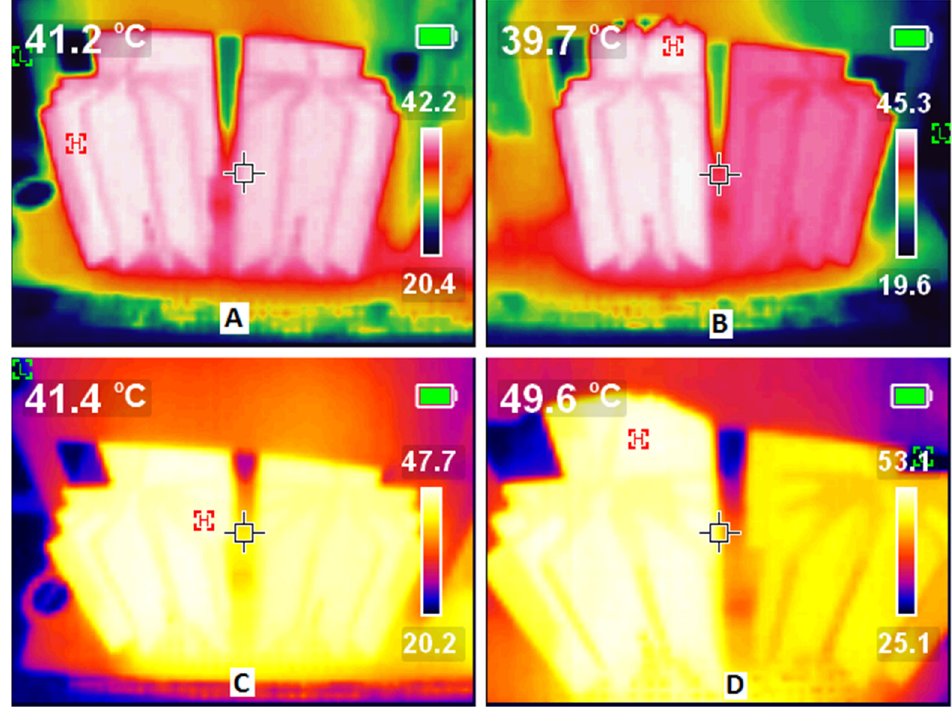
Figure 11. Infrared temperature measurements on the surface of the heatsink. ( A , C ) Appropriately selected transistors from the same production lot (Figure 7, graphics 1, 2); ( B , D ) transistors from different production lots (Figure 7 graphics 1, 4). The thermal measurements were performed with the infrared camera FLIR.